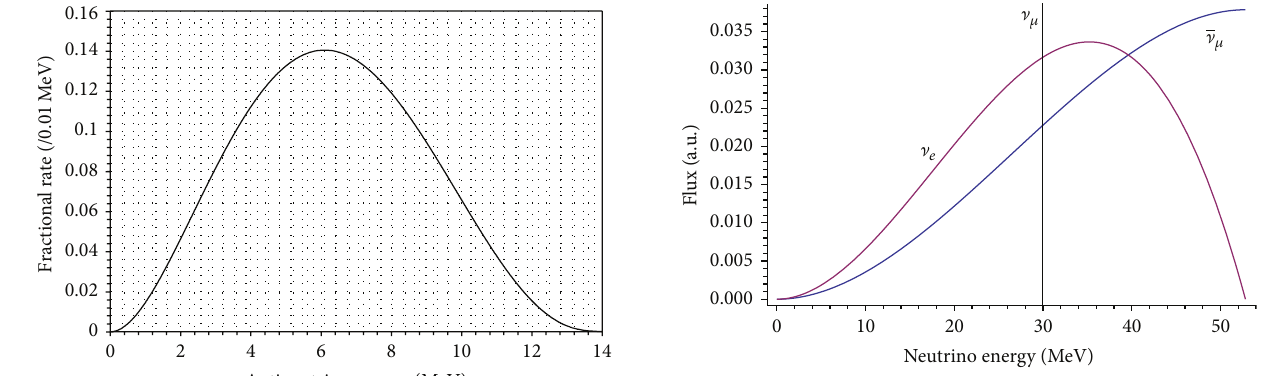
and the pions (and their decay products) produced in the events can lead to electron-like backgrounds.